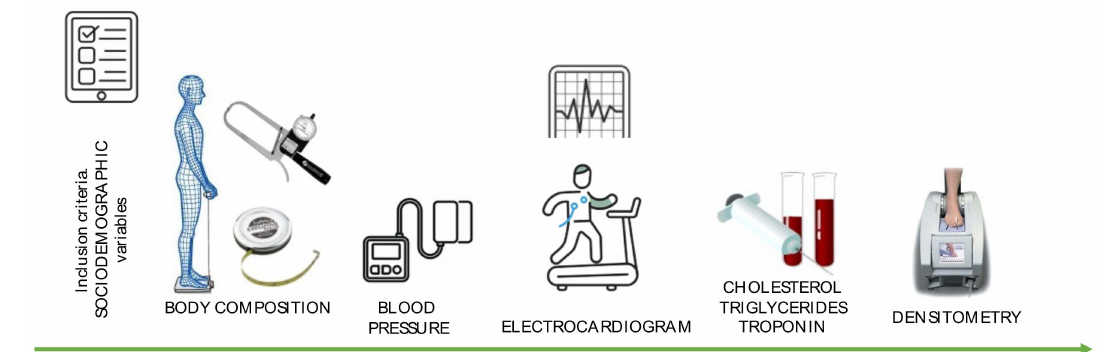
Figure 3. Summary of the assessment of health parameters included in the